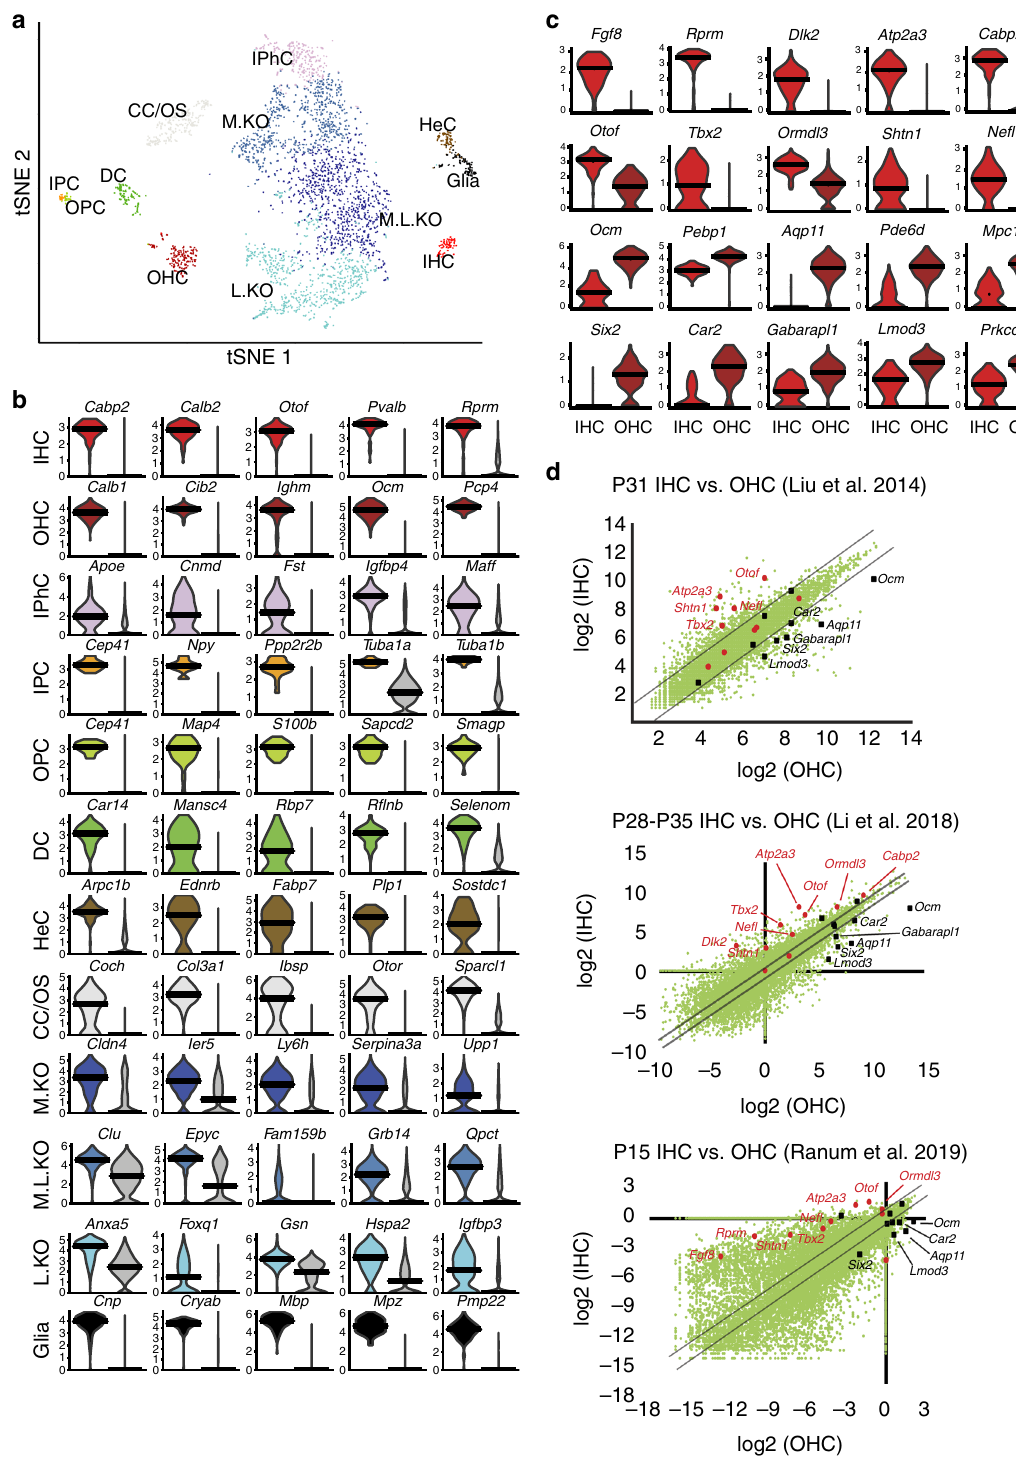
Fig. 6 Comparison of gene expression between IHCs and OHCs at P7 and in adults. a tSNE plot for ~3400 cochlear cells isolated from three separate experiments at P7. Speci fi c clusters for different cells types are labeled. b Violin plots showing relative expression of the top fi ve differentially expressed (DE) genes for each cell type (color coded as in a ) by comparison with all other P7 cells (gray on the right in each graph). c Violin plots for the top ten DE genes between P7 IHCs and OHCs. d Scatter plots comparing gene expression in IHCs vs. OHCs collected at the indicated ages in the indicated publications. Gray lines mark cutoffs for twofold differences in gene expression. Red and black dots indicate DE IHC and OHC genes, respectively, from P7. Names are included for those genes located outside of the twofold threshold. IHC inner HCs, OHC outer HCs, IPhC inner phalangeal cells/border cells,